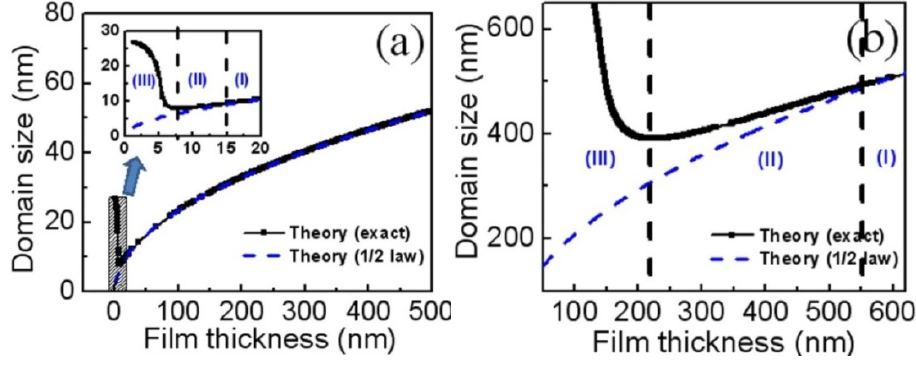
Figure 13. Thickness-dependent domain size scaling in 109° rhombohedral BFO films as ( a ) ferroelectric domains and ( b ) ferroelastic ones. (Reprinted with permission from [98]. Copyright 2013 American Institute of